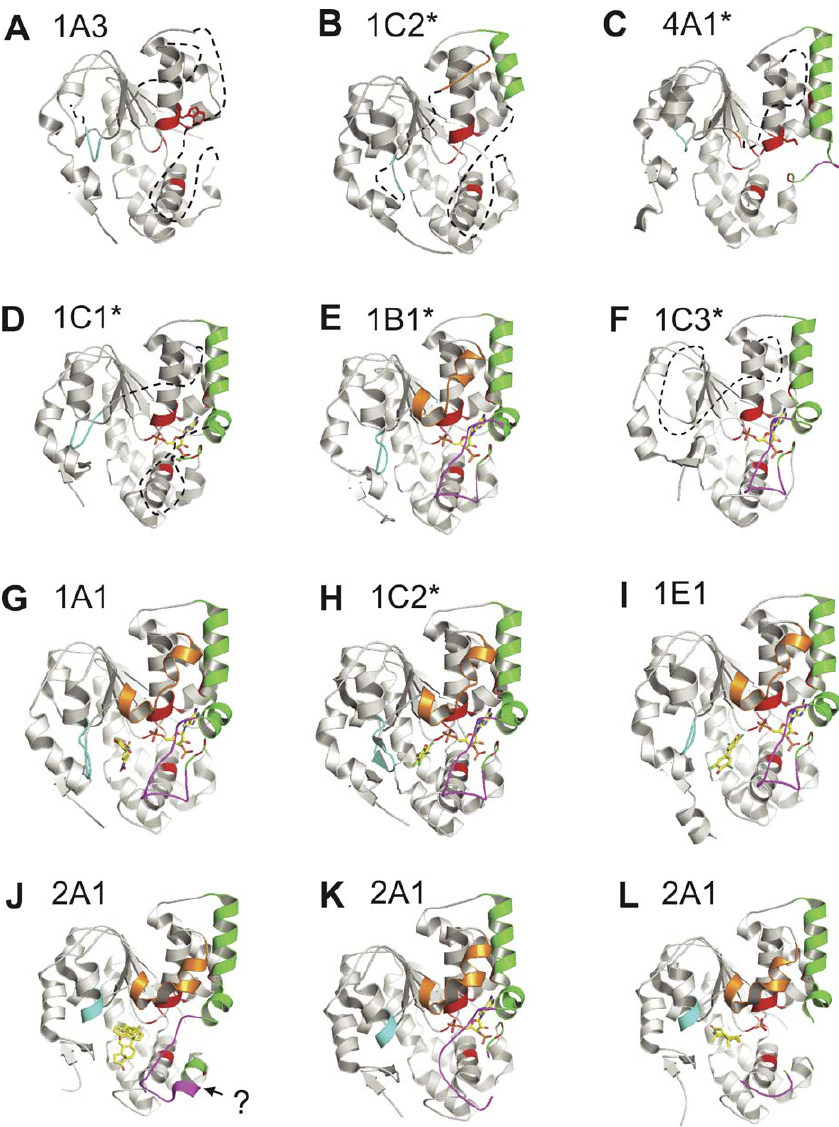
Figure 2. Representative Structures for Each of the hSULTs Grouped According to Similar Global Structural Features Apo proteins with considerable disorder in several loops: (A) SULT1A3 (1CJM), (B) SULT1C2 (2AD1), and (C) SULT4A1 (1ZD1). Structures with increased order due to binding of PAP (green helices, purple loop): (D) SULT1C1 (2ETG), (E) SULT1B1 (1XV1), and (F) SULT1C3 (2H8K). Ternary complexes display further ordering of substrate binding loops: (G) SULT1A1 with PAP and p -nitrophenol (1LS6), (H) SULT1C2 with PAP and PCP (2GWH), and (I) 1E1 with PAP and 3,5,3 9 ,5 9 -tetrachloro-biphenyl-4,4’-diol (1G3M). Structures with unusual features that likely reflect catalytically unproductive proteins: (J) SULT2A1 bound to DHEA, but without PAP (1J99); compare to (K) structure of the same protein with PAP (1EFH), and (L) with androsterone (1OV4). The structures we solved are labelled with an asterisk. The question mark (?) indicates a helix formation, which leads to a non-productive conformation. The Protein Data Bank code for each structure is shown in parentheses. The proteins are represented by a ribbon model; PAP and substrate are shown as stick models coloured per element (carbon in yellow, oxygen in red, nitrogen in blue, and phosphate in magenta). The loops are coloured as discussed in the text (gold, cyan, green, and purple).